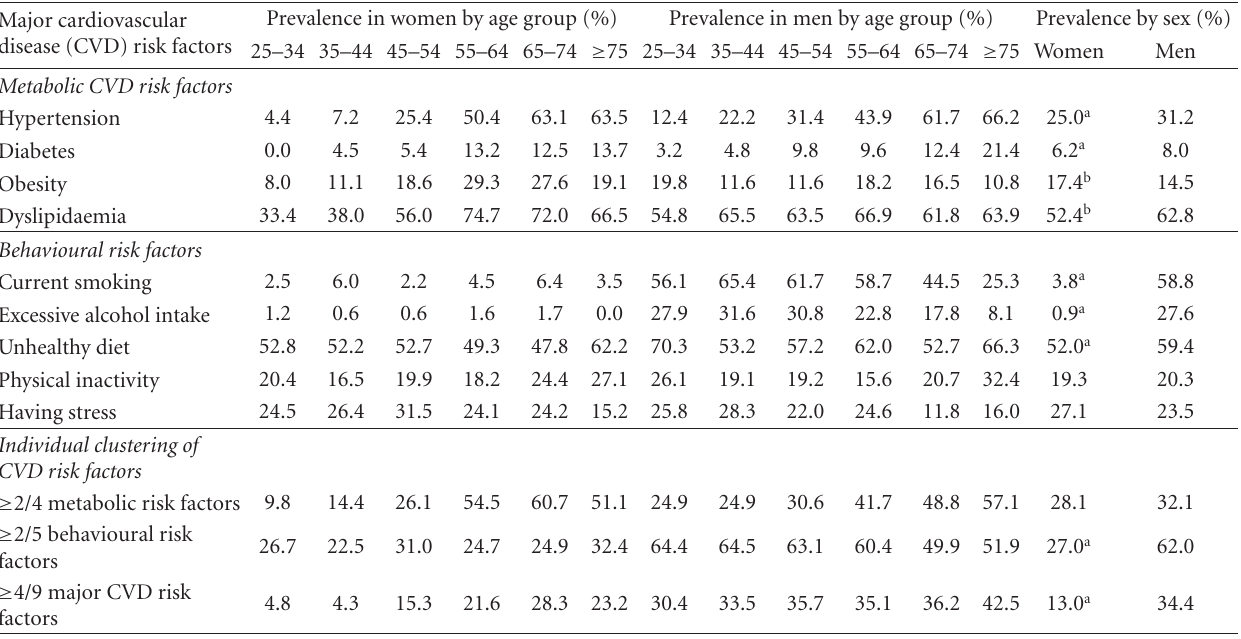
Table 2: Prevalence of cardiovascular diseases risk factors in a studied population of Vietnamese adults stratified by sex and age group.